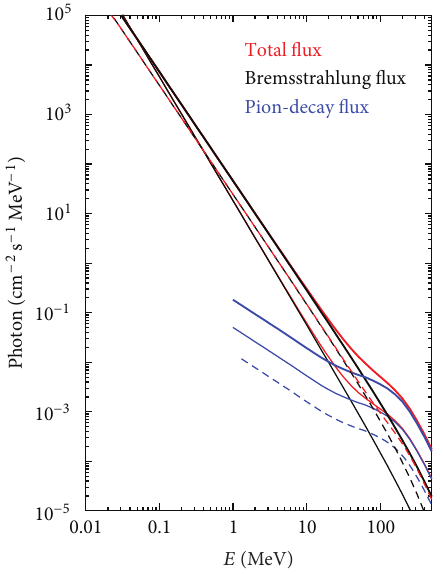
Figure 2: Restored energy spectra of gamma-rays for different time intervals. Thin lines correspond to 16:31:02–16:31:14, thick lines to 16:31:38–16:31:46, and dashed lines to 16:32:02–16:32:10. Red curves represent the total spectra, black curves electron bremsstrahlung, and blue curves the pion-decay component.